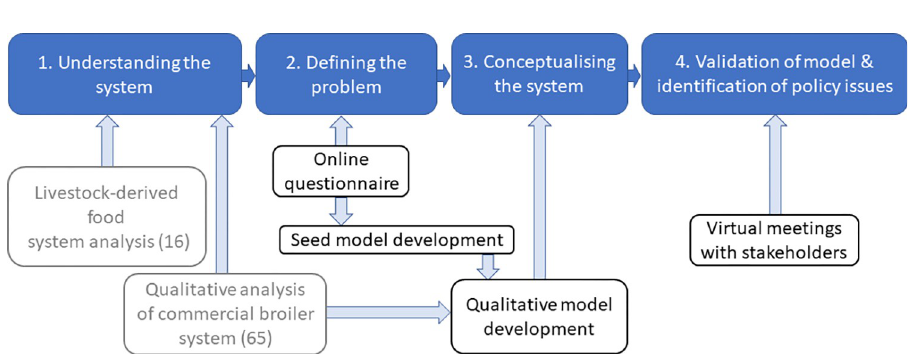
Fig 1. Four stages of research (in blue) and the inputs for each (previously published in grey, current study in black).